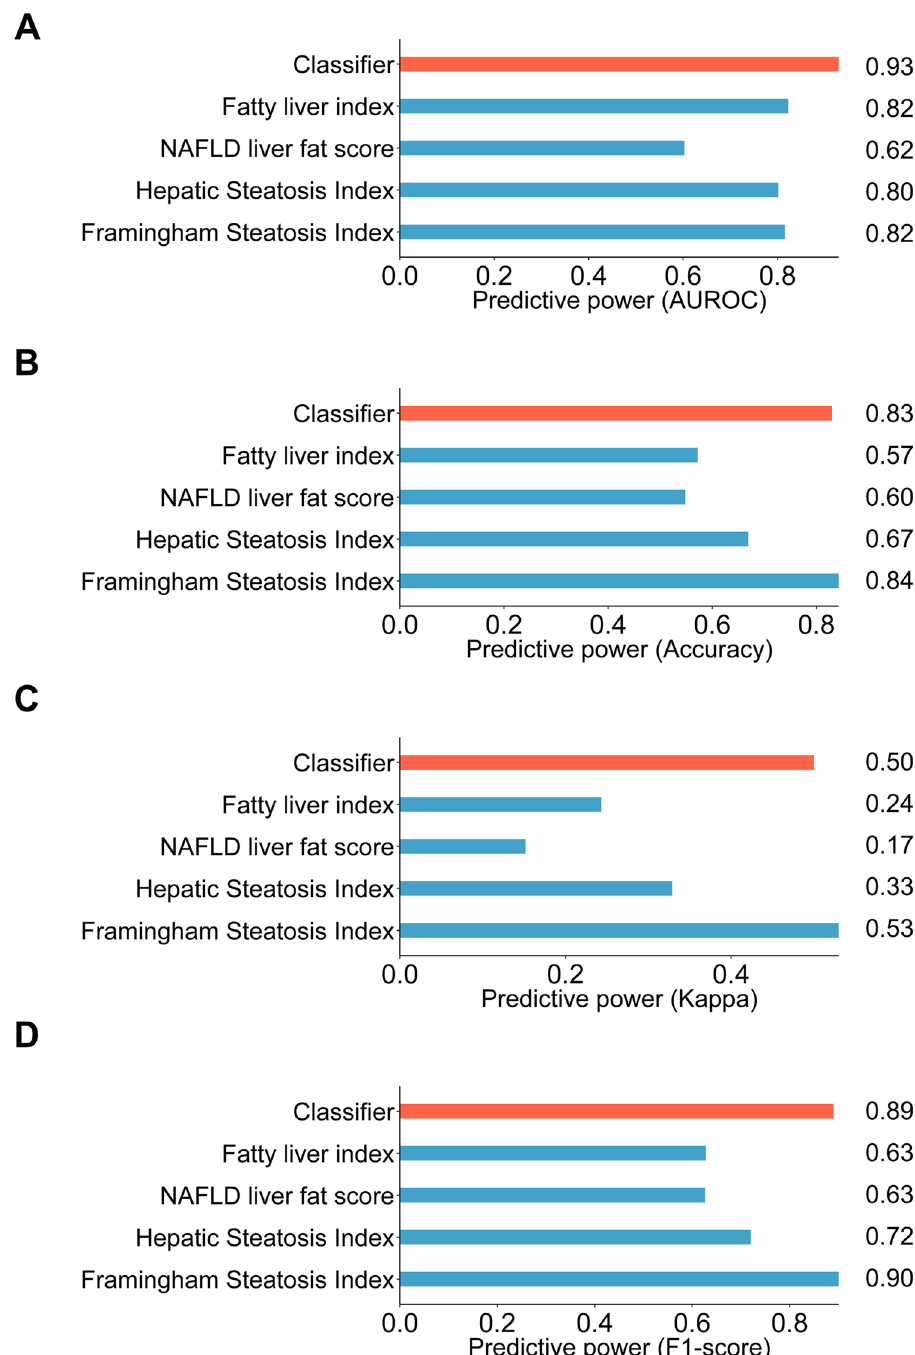
Figure 6. Evaluating prediction using GA-optimized classifier differentiating IRFL from IRNF. Bar plots comparing the predictive power derived from the test dataset using the GA-optimized classifier with other predictors by ( A ) AUROC, ( B ) accuracy, ( C ) kappa, and ( D ) F1 score. IRFL: fatty liver participants featuring insulin resistance; IRNF: nonfatty liver control group featuring insulin